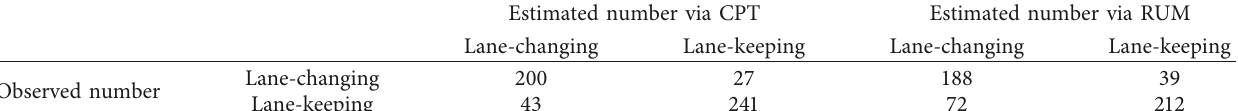
Table 6: Prediction confusion matrix of data set II based on CPT and RUM.